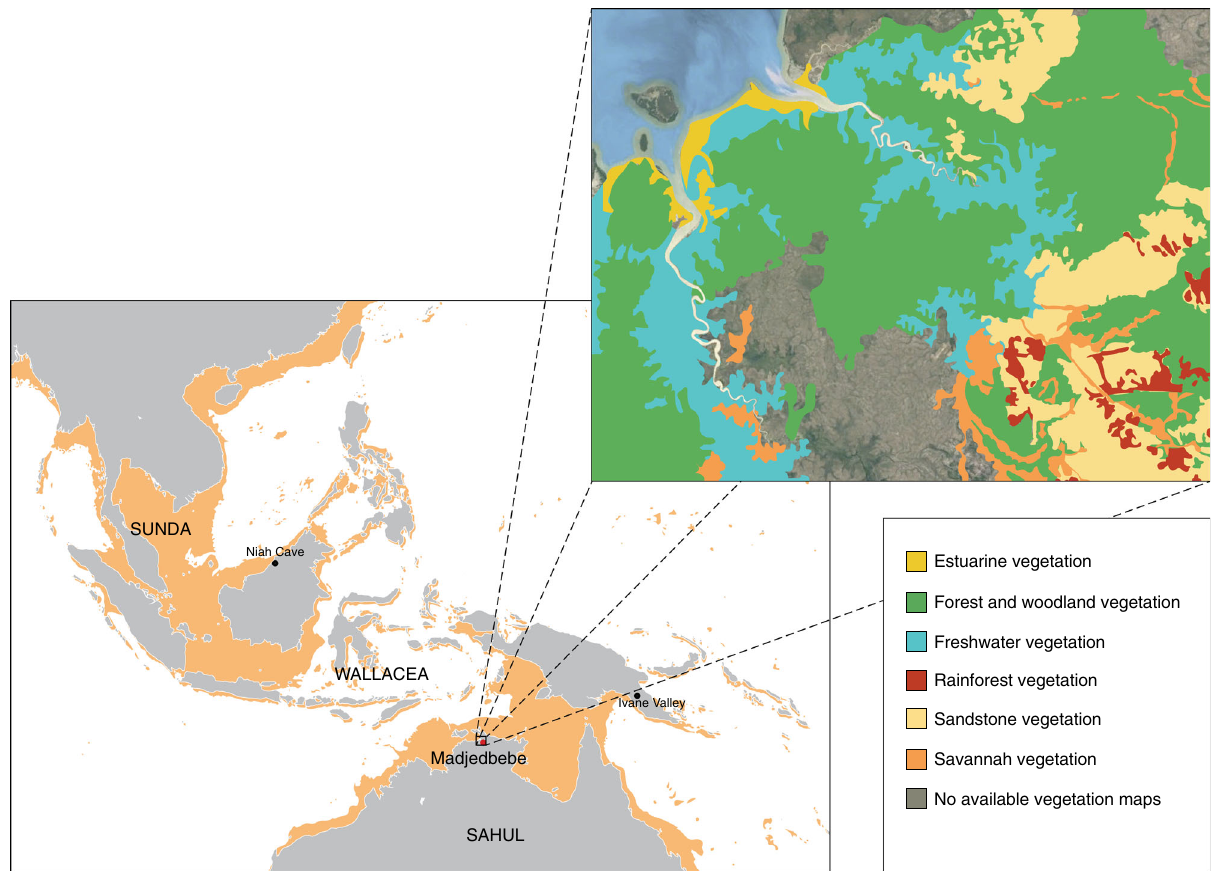
Fig. 1 Site location. a Regional map showing the location of Madjedbebe, and other sites mentioned in-text, adapted from Norman et al. 2018 47 ; b current distribution of vegetation communities in proximity to Madjedbebe, developed from map data provided by Google, Landsat/Copernicus, TerraMetrics, and vegetation maps of the Adelaide and Alligator Rivers area 48,49